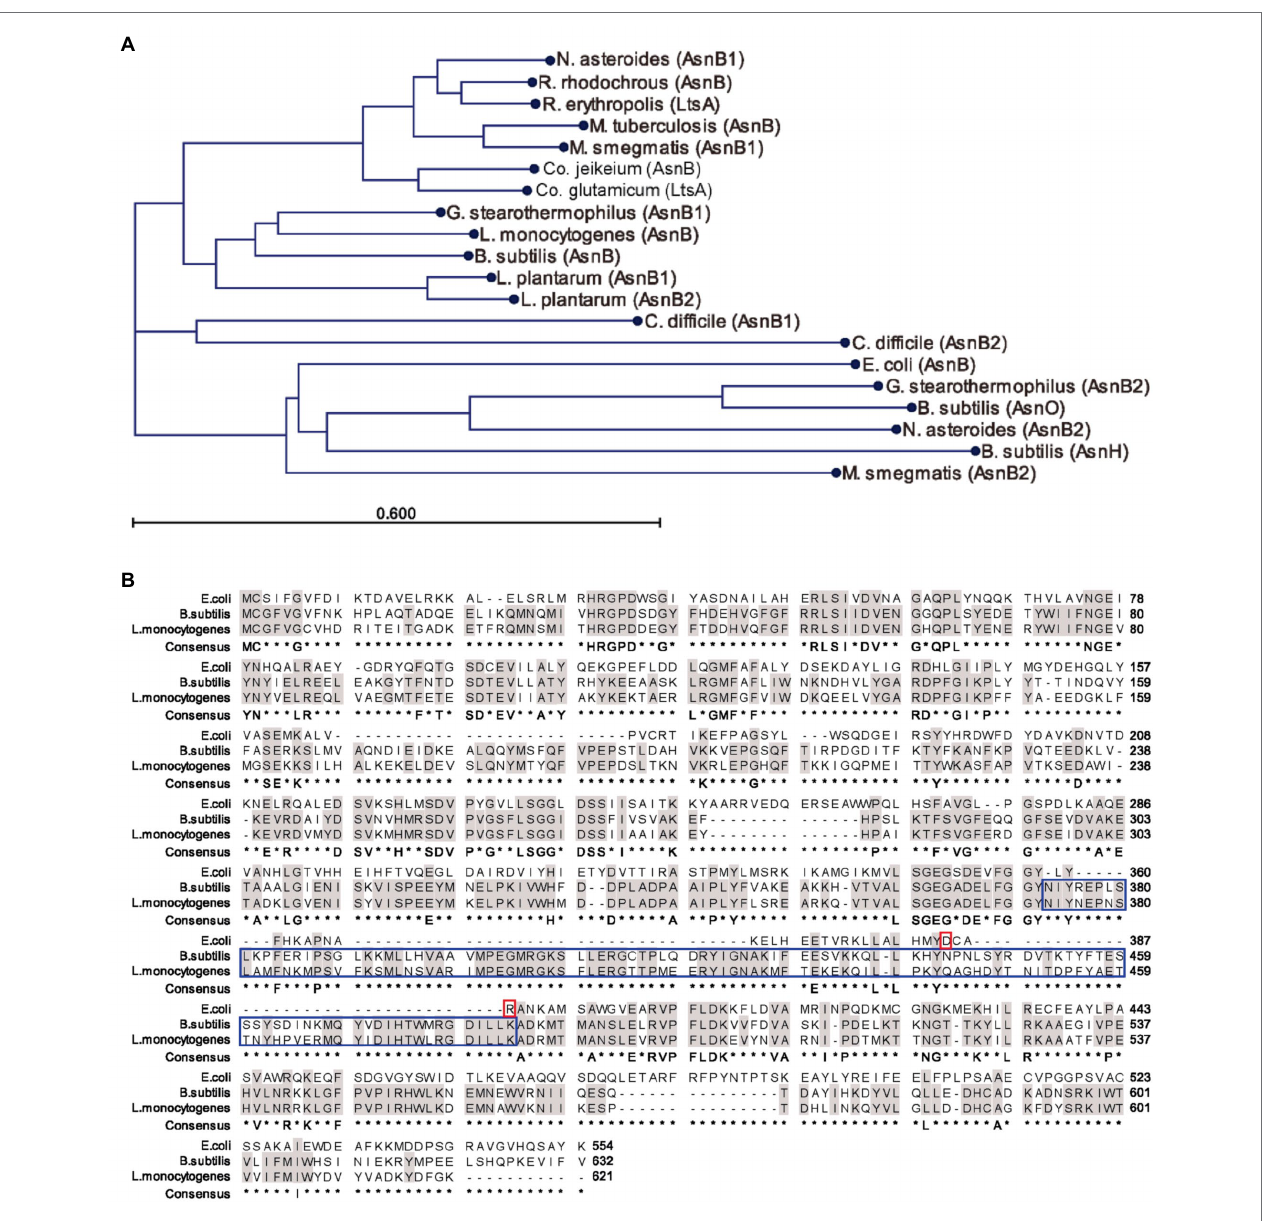
FIGURE 5 | Sequence comparison of AsnB proteins from selected bacteria. (A) Phylogenetic tree of AsnB homologs from several Gram-positive bacteria and from Escherichia coli , all of which contain m DAP in their PG. Bacterial genera: B, Bacillus ; C, Clostridioides ; Co, Corynebacterium ; E, Escherichia ; G, Geobacillus ; L, Lactobacillus ; M, Mycobacterium ; N, Nocardia ; and R, Rhodococcus . (B) Sequence alignment of AsnB from L. monocytogenes , Bacillus subtilis, and E. coli . Identical residues between the three proteins and between AsnB from B. subtilis and L. monocytogenes are highlighted in gray color. Conserved Asp-binding residues (Ahn, 2013) in AsnB of E. coli are highlighted with a red box. The extra amino acid loop characteristic of m DAP-amidating AsnB homologs is highlighted with a blue